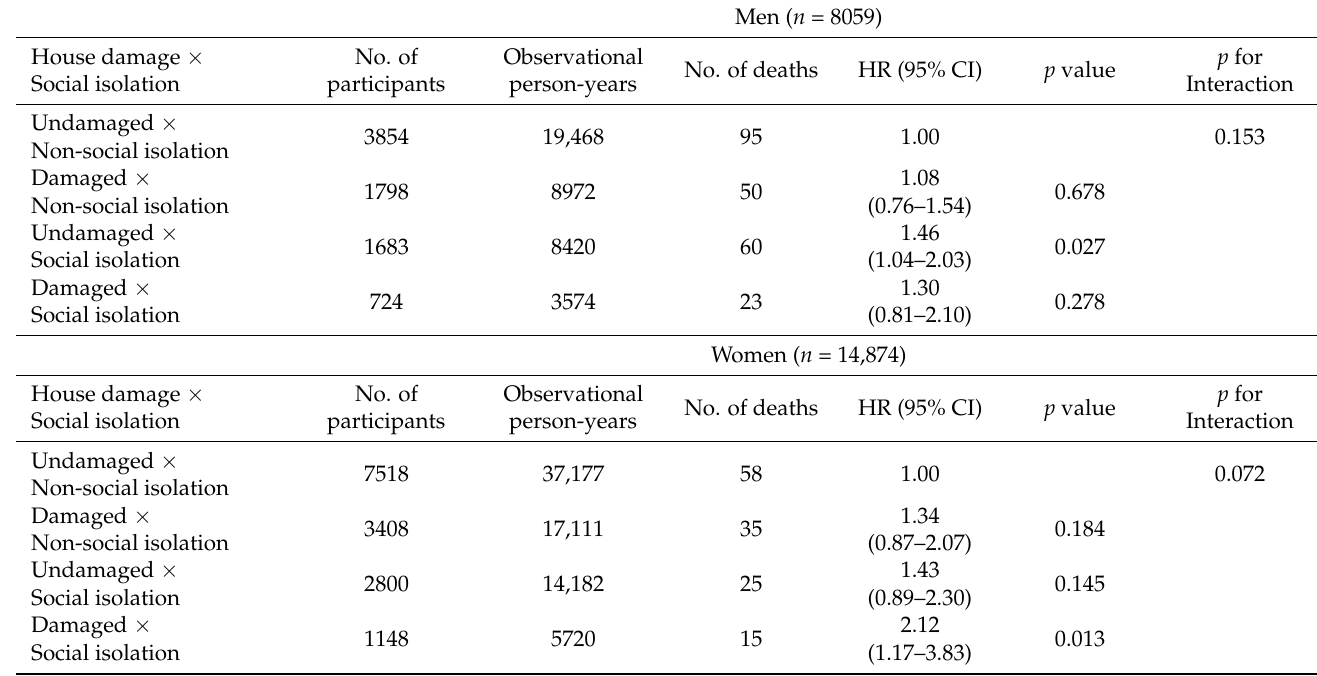
Table 4. Adjusted HRs (95% CI) of mortality according to house damage and social isolation. Men ( n =